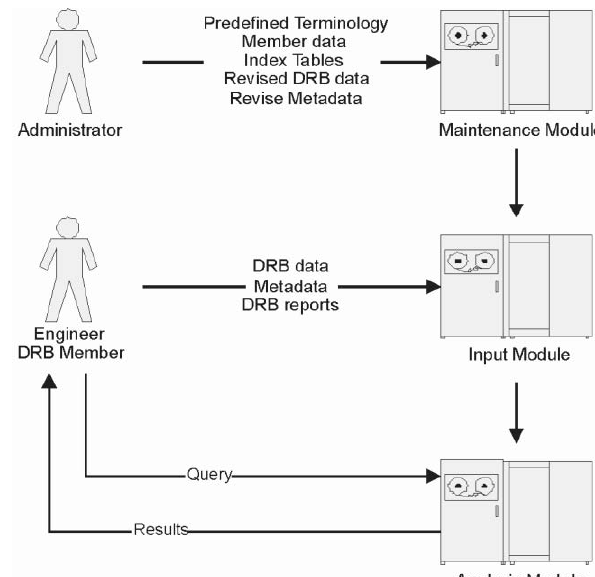
Fig. 1. Workflow of the DRB System